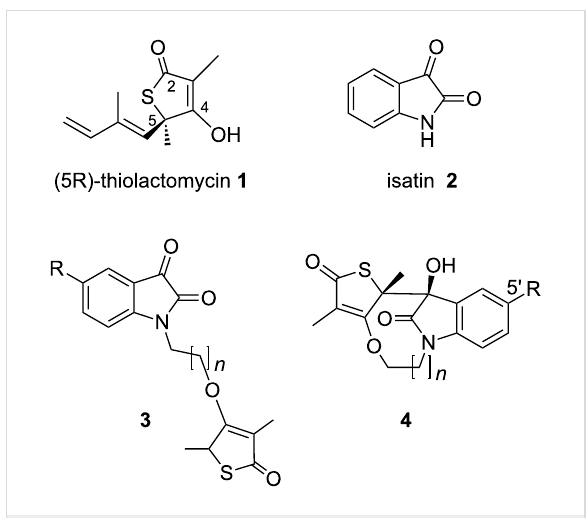
Figure 2: Structures of thiolactomycin ( 1 ), isatin ( 2 ), the desired hybrid 3 and tetracycle 4 .